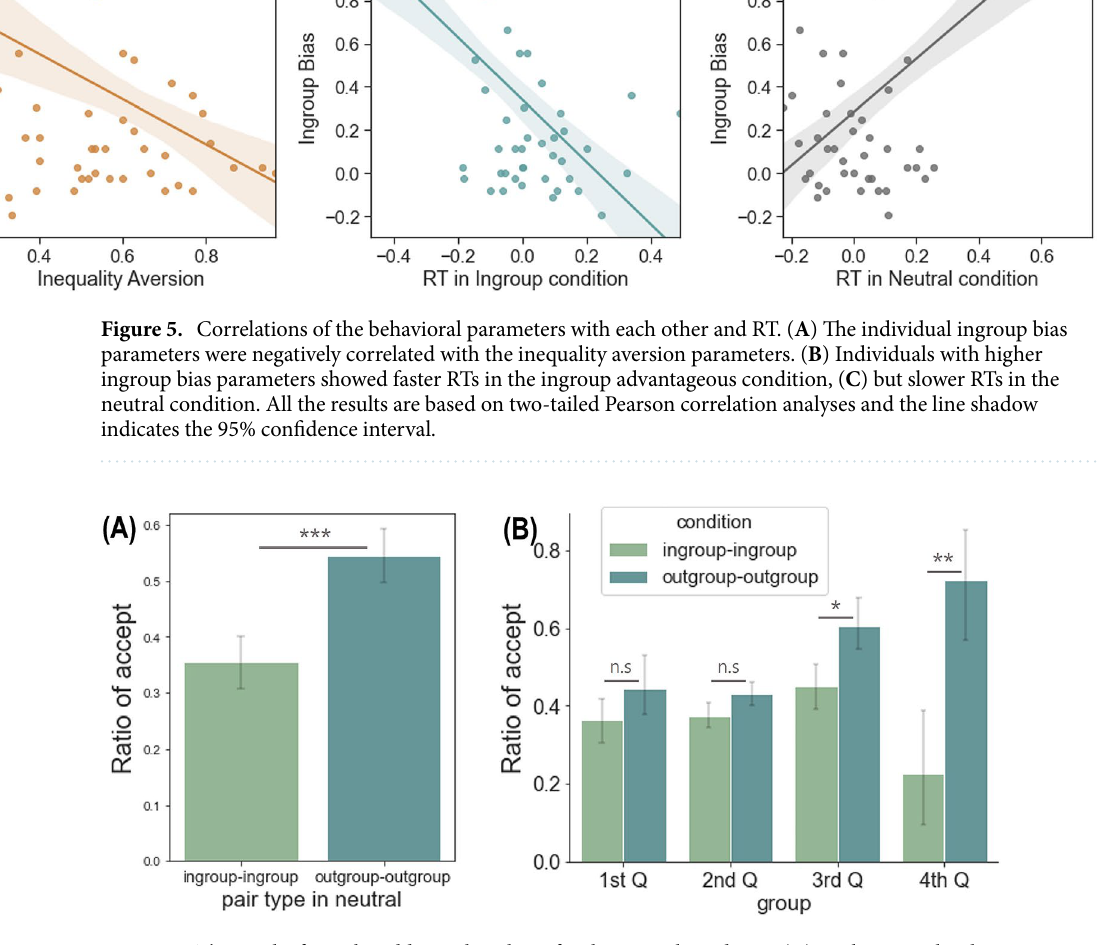
Figure 6. The results from the additional analyses for the neutral condition. ( A ) At the group level, participants accepted more in the outgroup-outgroup neutral condition than the ingroup-ingroup neutral condition. ( B ) We divided participants into four groups based on their sensitivity to the ingroup bias. The first group consisted of those with the lowest ingroup bias whereas the fourth group consisted of the highest. The differences in acceptance rate between each condition were mainly driven by the fourth and third quartile groups. The error bars indicate the within-subject 95% confidence interval 46 . * p < 0.05, ** p < 0.01, *** p <